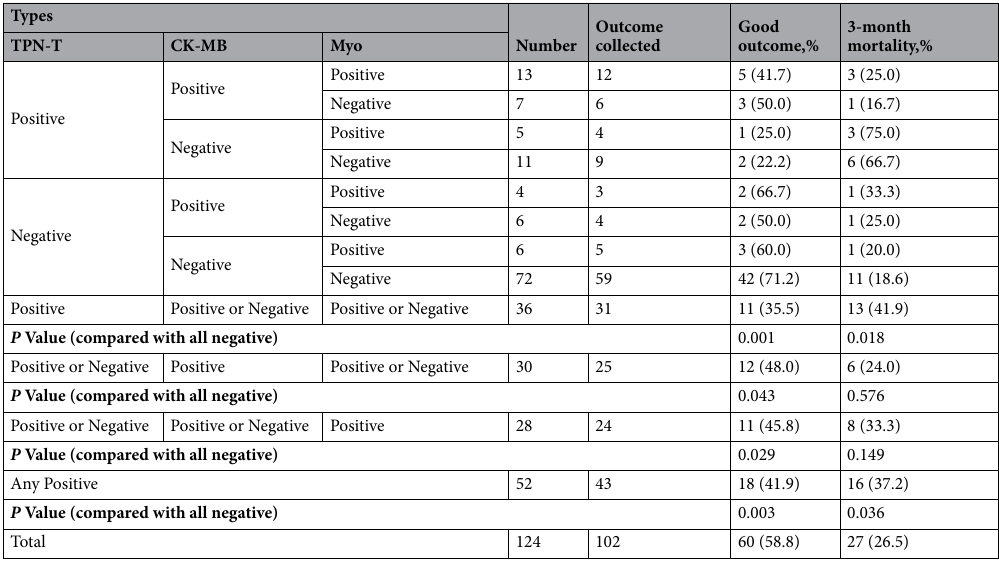
Table 3. Clinical